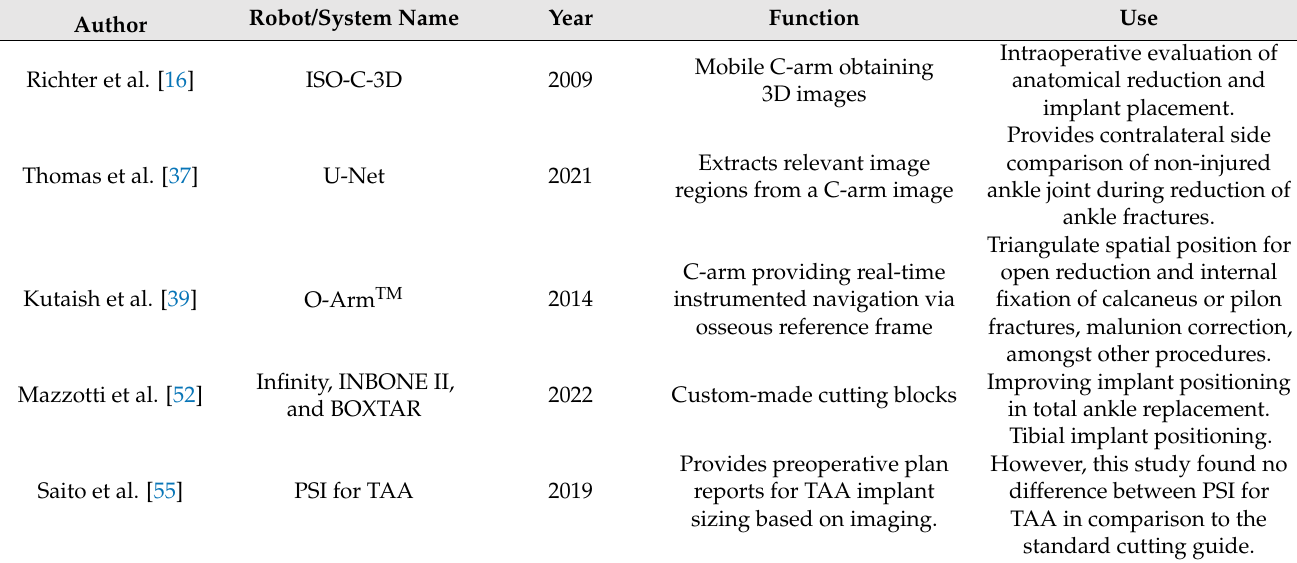
Table 2. Clinical Intraoperative device applications in foot and ankle